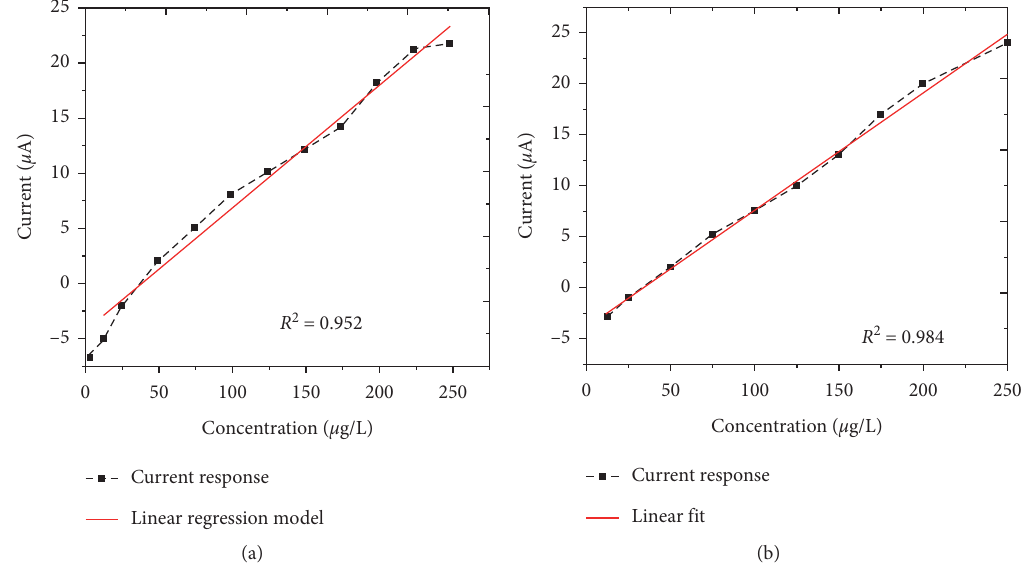
Figure 7: Calibration curve for (a) Se (IV) and (b) Ni (II) in the concentration range of 5–250 μ g/L in 0.1 M PBS and 5mM Fe(CN) Mn 3 O 4 -Cn electrode at 25 °